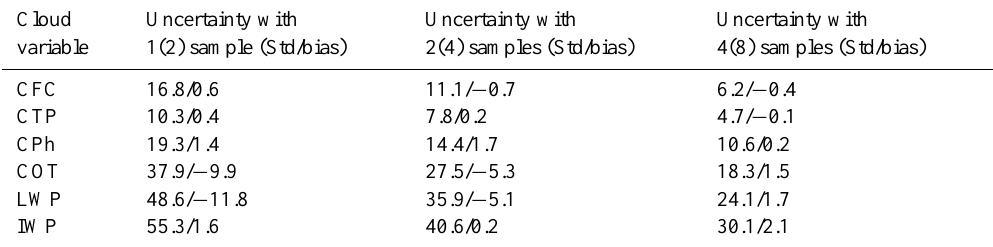
Table 5. Sampling uncertainty given in relative standard (std) and mean (bias) deviation over SEVIRI’s disc. All values are given in % and were calculated for one (14:00UTC), two (11:00, 14:00UTC) and four (09:00, 11:00,14:00, 16:00UTC) samples a day. For CFC and CTP also the + 12h slot was included, thus the sampling for these two variables contain two, four and eight